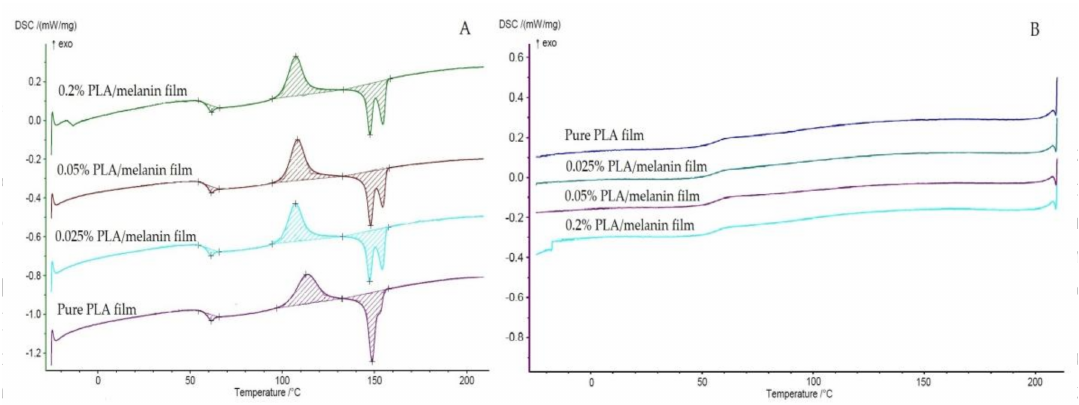
Figure 7. The DSC curves of pure PLA and PLA/melanin modified films ( A ) second heating scan ( B ) cooling.